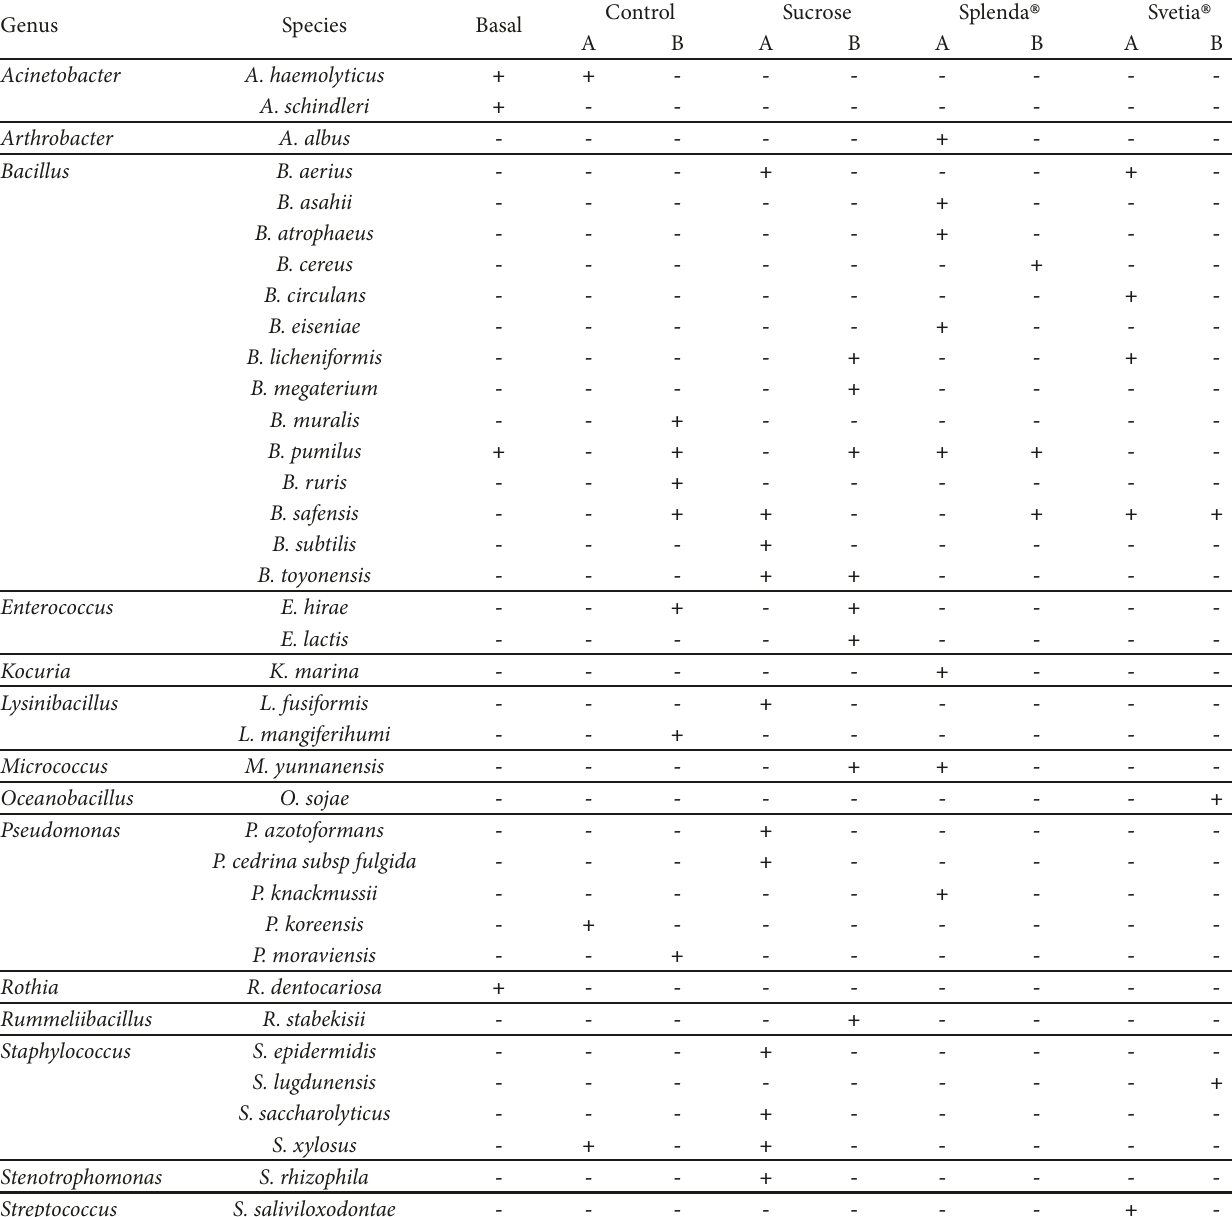
Table 7: Distribution of genera and species identified by study